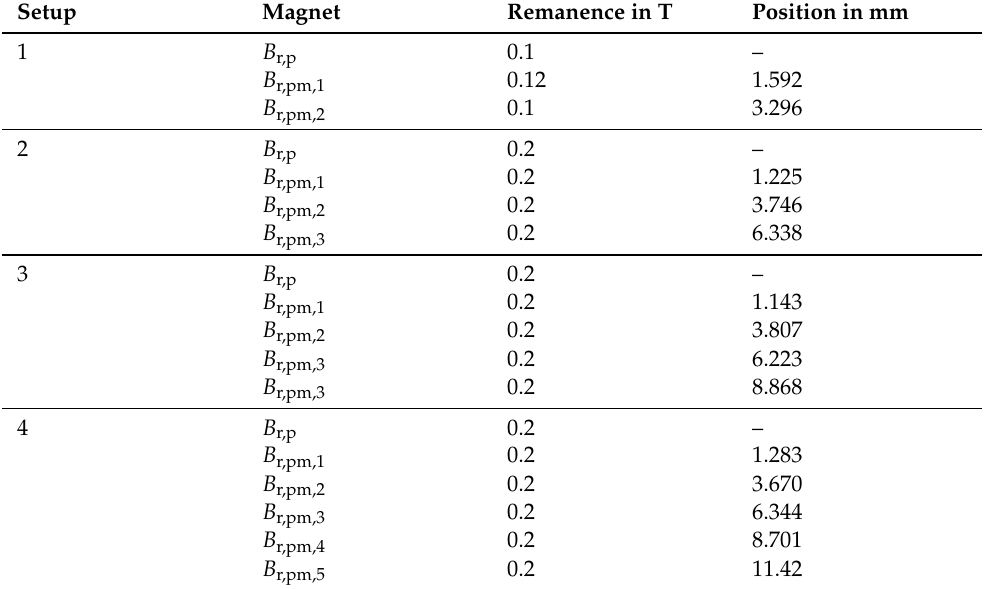
Table 2. Experimental Setups 1–4 and respective parameters used to generate multiple equilibrium positions.